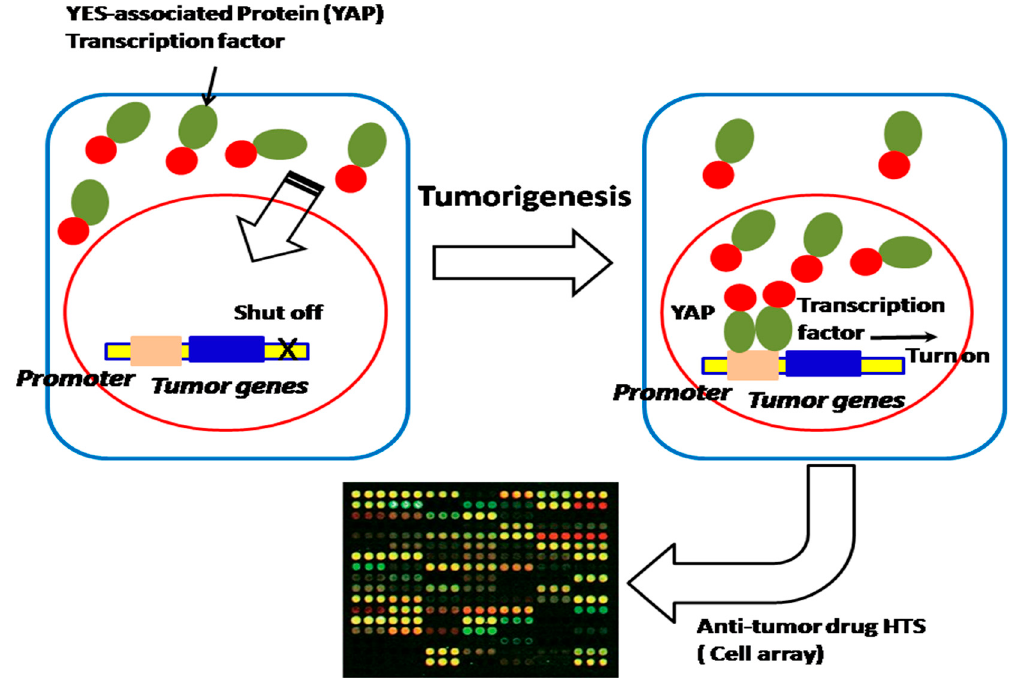
Figure 6. A performance-enhanced promoter is applied for the construction of an HTS platform for HTS of anti-tumor drugs and studying nucleocytoplasmic shuttling regulating factor YAP’s nucleocytoplasmic localization and tumorigenesis, which controls tumor growth and invasion.